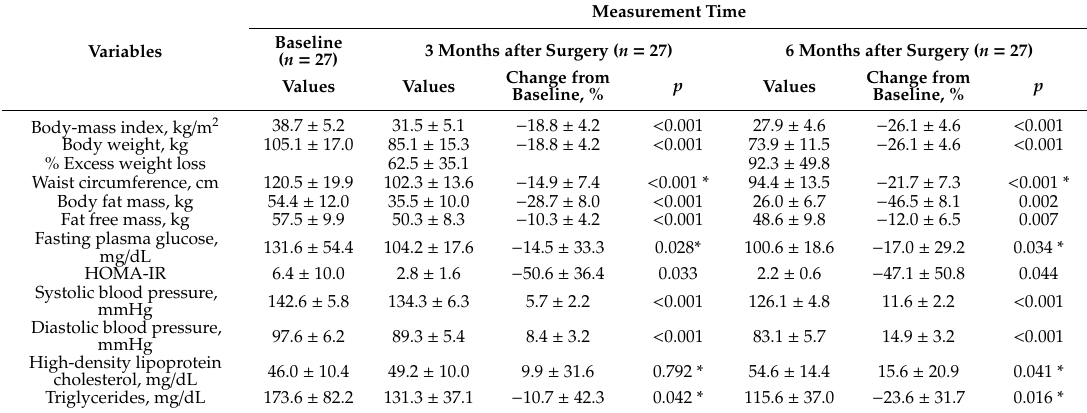
Table 2. Average values and percentage changes at three and six months after sleeve gastrectomy. Measurement Time Baseline = 27) Variables ( n = 27) 3 Months after Surgery ( n Values